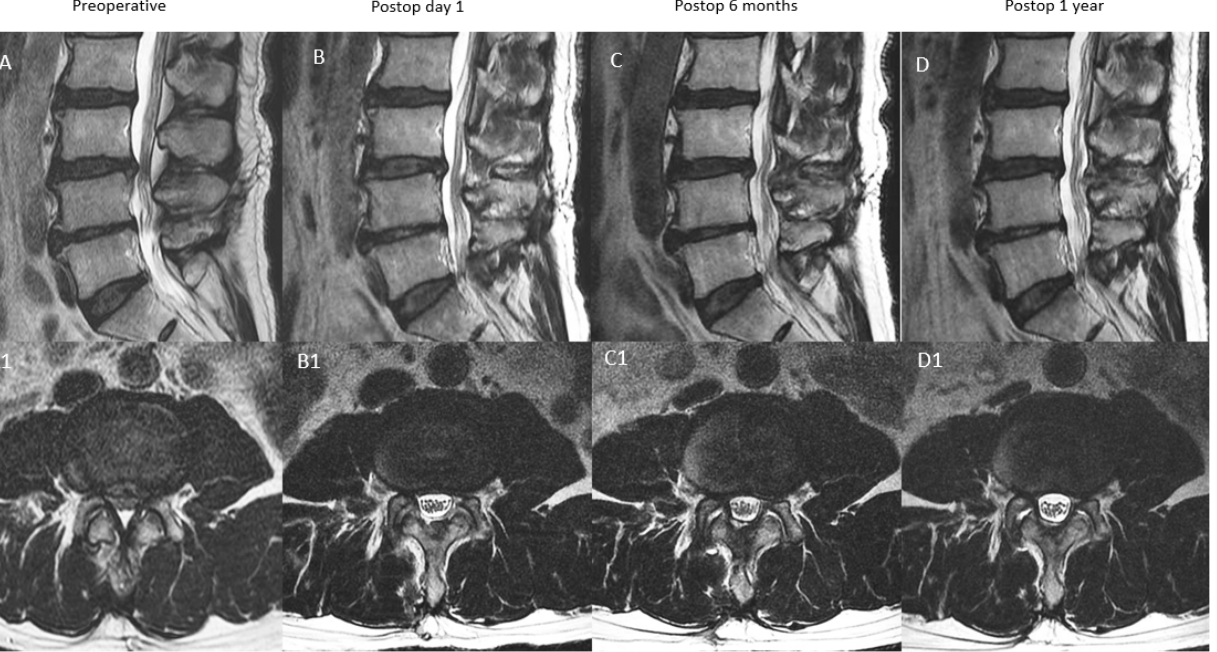
Figure 5. MRI appearance of remodeling patterns at preoperative, postoperative day 1, postopera- tive 6 months and postoperative 1 year with mid-sagittal cut in the top row and corresponding axial cut in the bottom row. type B: remodeling type, preoperative spinal stenosis of L3/4 ( A , A1 ) with increased spinal canal area on postoperative day one MRI ( B , B1 ). There was moderate restenosis that occurred at postoperative 6 months ( C , C1 ), which improved modestly at postoperative one year with overall improved spinal canal area ( D , D1 ).